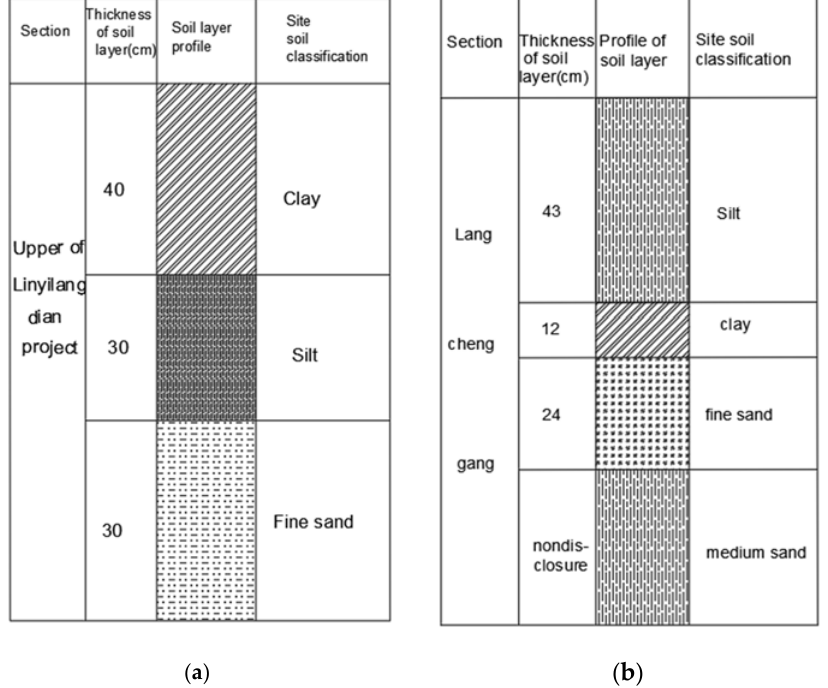
Figure 2. Stratification of riverbed in typical wandering reach of the Yellow River: ( a ) Xiaobei main stream reach; ( b ) Downstream Langchenggang section.